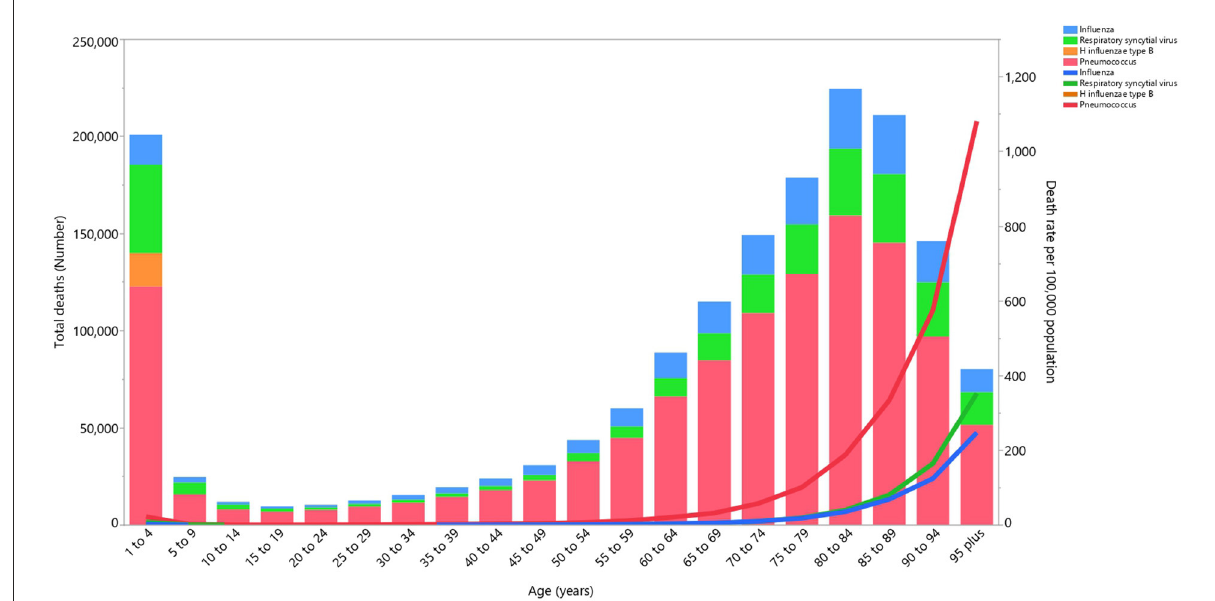
FIGURE6 Percentage of DALYs due to lower respiratory infections attributable to risk factors for 21 GBD regions in 2019. DALY, disability adjusted life years (generated from data available from http://ghdx.healthdata.org/gbd-results-tool).